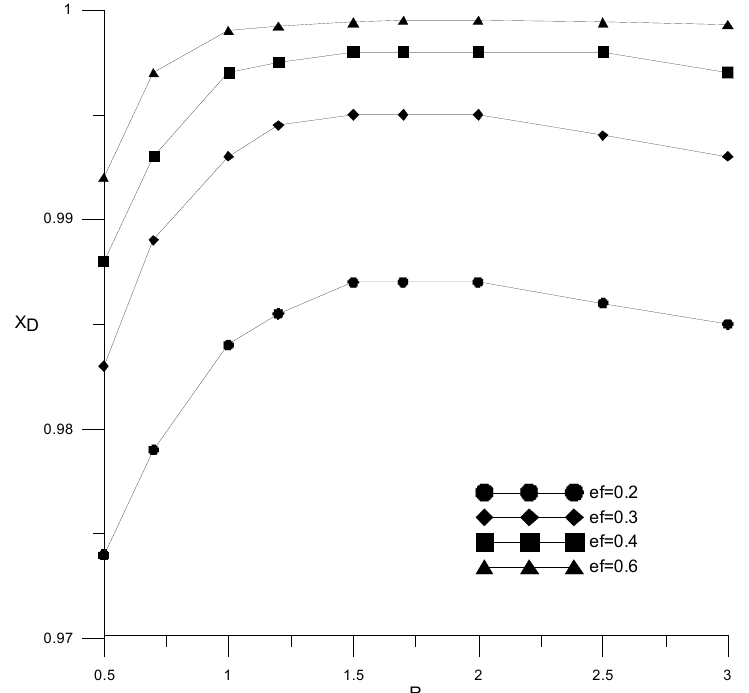
Figure 11. Influence of reflux ratio on ethanol concentration in distillate with different amounts of extractant.